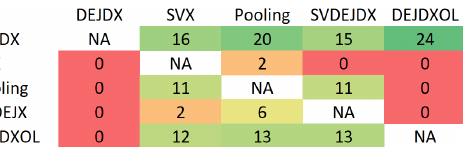
Figure 11. The results of the Diebold-Mariano tests at a significance level of 0.05 and for 24 h of the day with the pinball 10% tails scoring rule in the out-of-sample period (2 January 2017–26 March